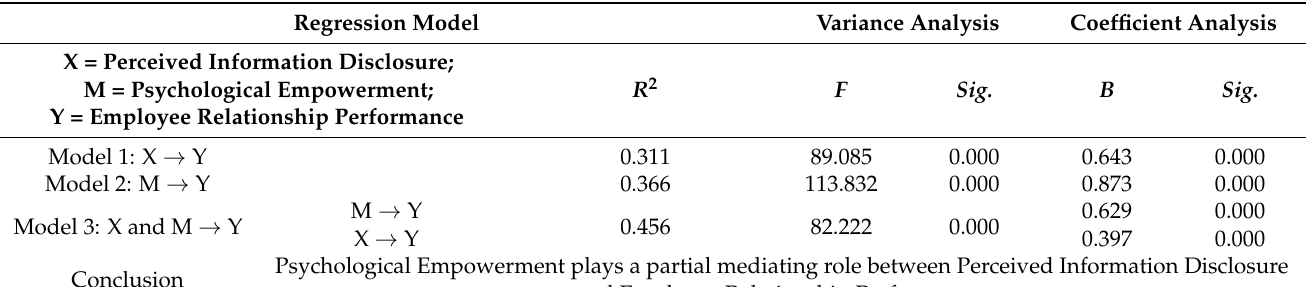
Table 25. Test of the Mediating Effect of Psychological Empowerment between Perceived Information Disclosure and Employee Relationship